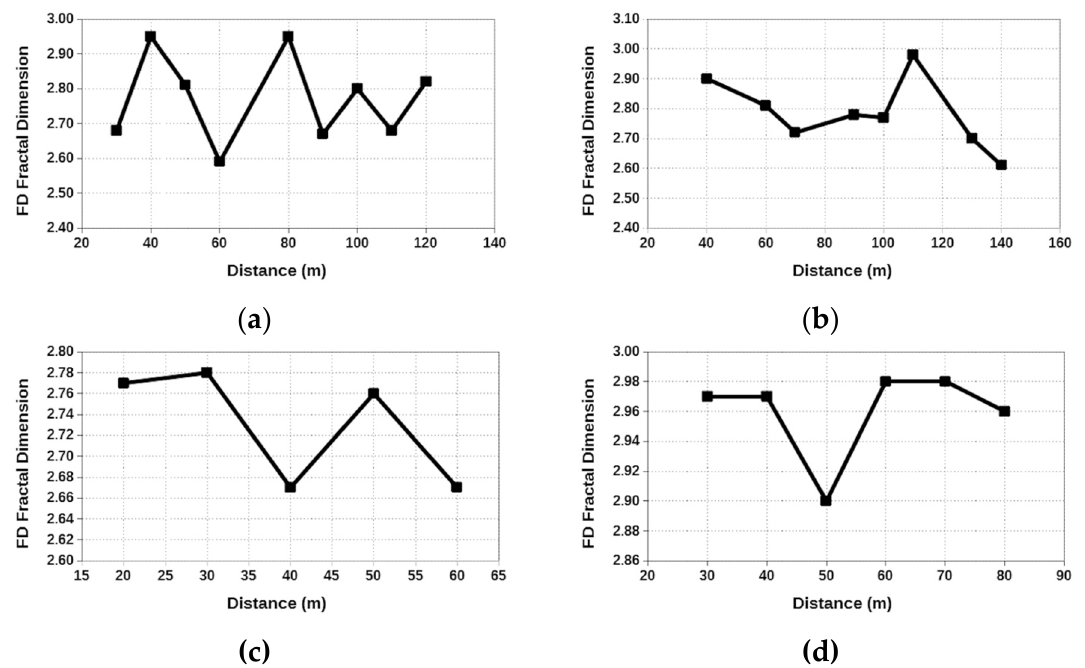
Figure 6. Fractal dimension (FD) values with different distances in the four spatial directions. ( a ) FD values in the horizontal direction. ( b ) FD values in the vertical direction. ( c ) FD values in the 45° direction. ( d ) FD values in the 135° direction.